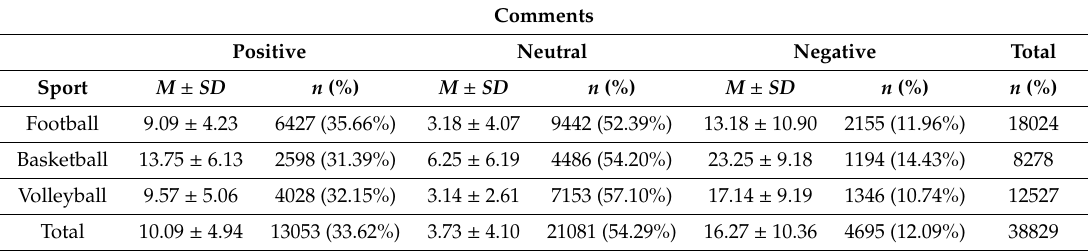
Table 3. Average, standard deviation, number, and percentage of comments (according to their nature and established by